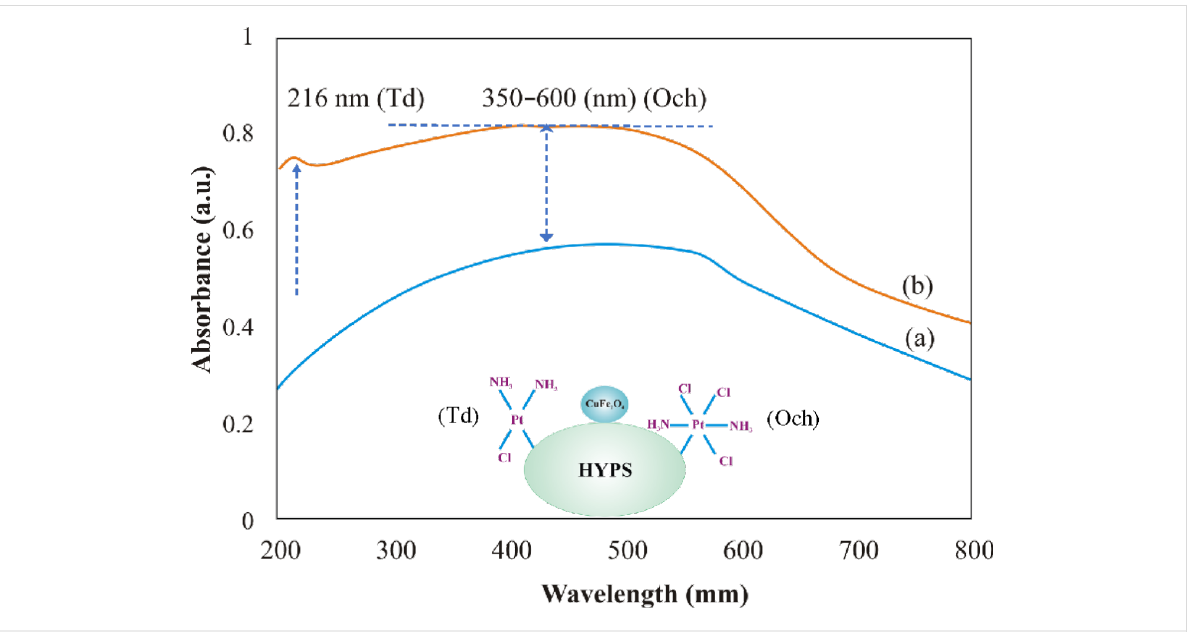
Figure 6: DR-UV–visible spectra of (a) CuFe 2 O 4 /HYPS and (b) cisplatin/CuFe 2 O 4 /HYPS.